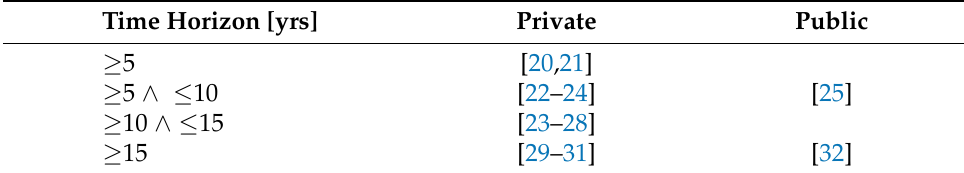
Table 1. Time horizon in literature for planning charging